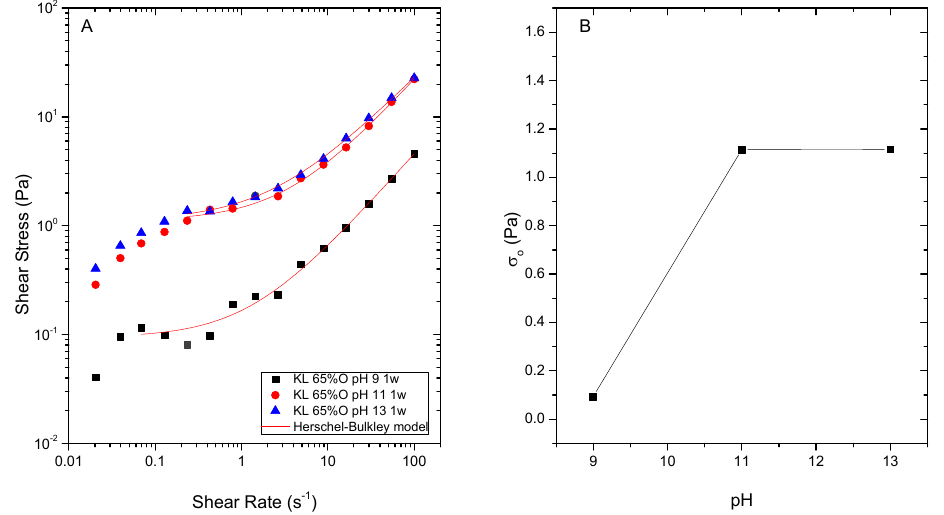
Figure 6. Effect of emulsification pH on silicone emulsions flow behaviour ( A ) and yield stress values ( B ) determined from Herschel-Bulkley model All emulsions were formulated with 65 wt.% O, stabilized by 0.5 wt.% Kraft lignin and measured after 1 week storage.